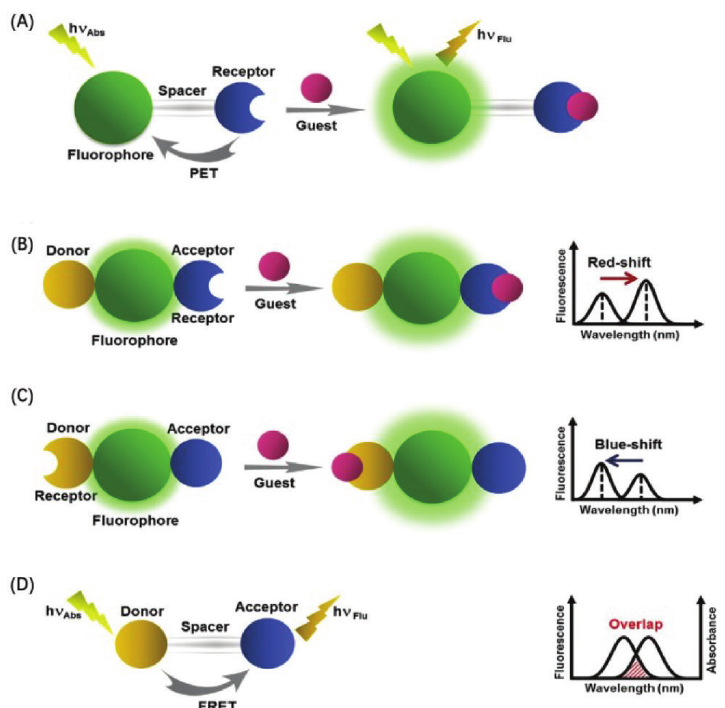
Figure 1: Design principle of nanometer fluorescent probe: (a) PET, (b,c) ICT, (d) FRET. Reprinted image with permission from Ref. [20], Copyright 2019, Elsevier